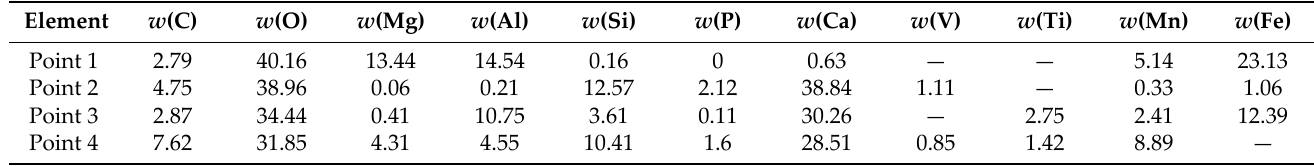
Figure 5. Sr‑12 SEM morphology, surface sweep, and energy spectra of points. Table 3. Sr‑0 SEM point element distribution (mass fraction, %).